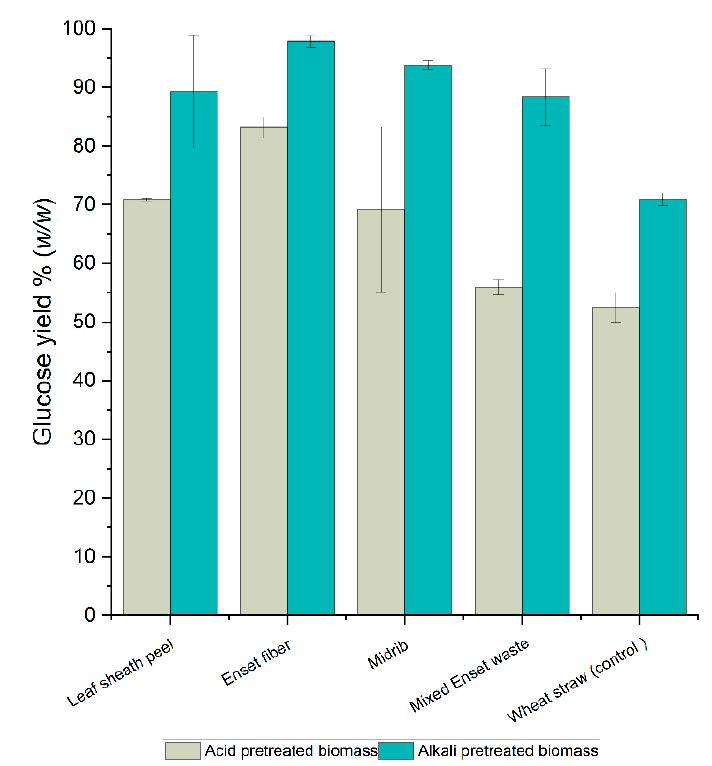
Figure 4. Comparison of the glucose yield after 72 h of enzymatic hydrolysis for acid- and alkali- pretreated Enset biomass samples.